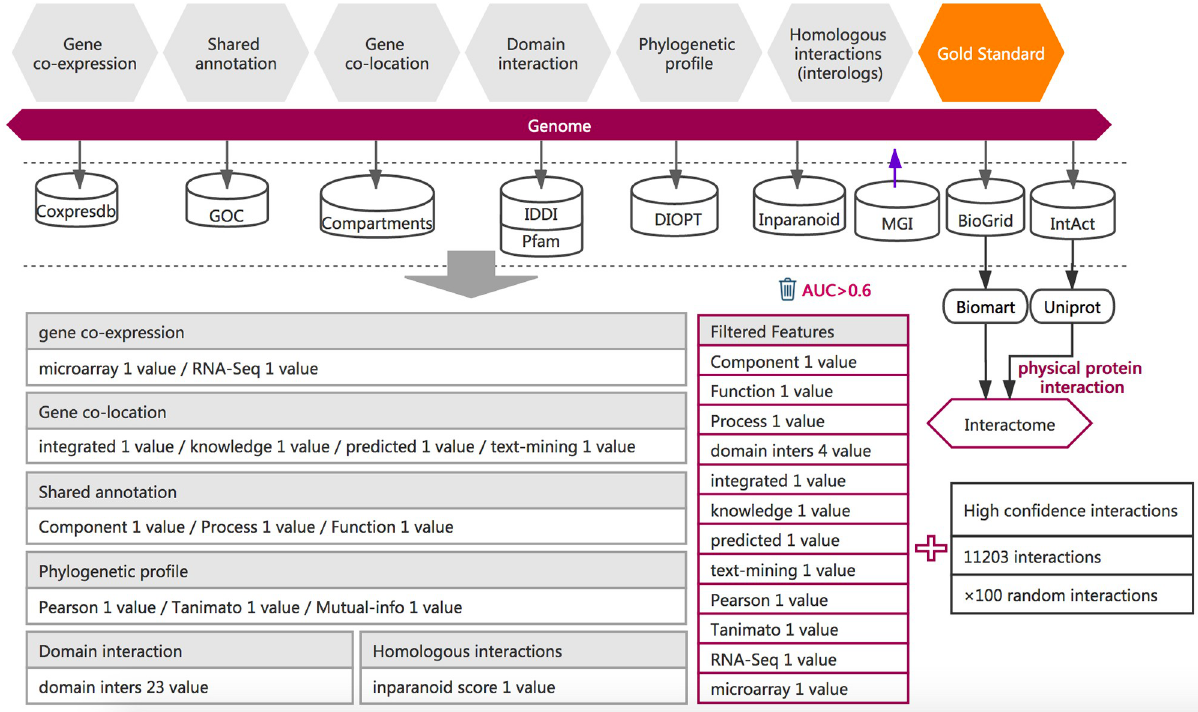
Fig 1. The workflow for the prediction of functional associations between mouse genes. The training dataset consists of 1). Positive examples. High- quality protein interactions that were reported in at least two databases were used as positive examples. 2). Negative examples. Random gene pairs that did not overlap with the positive examples (positive: negative = 1:100). 3) Functional association evidence. Six types of functional association evidence data were collected from 9 databases. 36 different mathematical characterizations of these six types of evidence data produce 36 feature values, which were described in S2 Table. A total of 15 high-quality features (AUC > 0.6) were selected as high-quality features and were used for functional association inference. Details of the feature computing methods can be found in the MID website (the section of Indirect